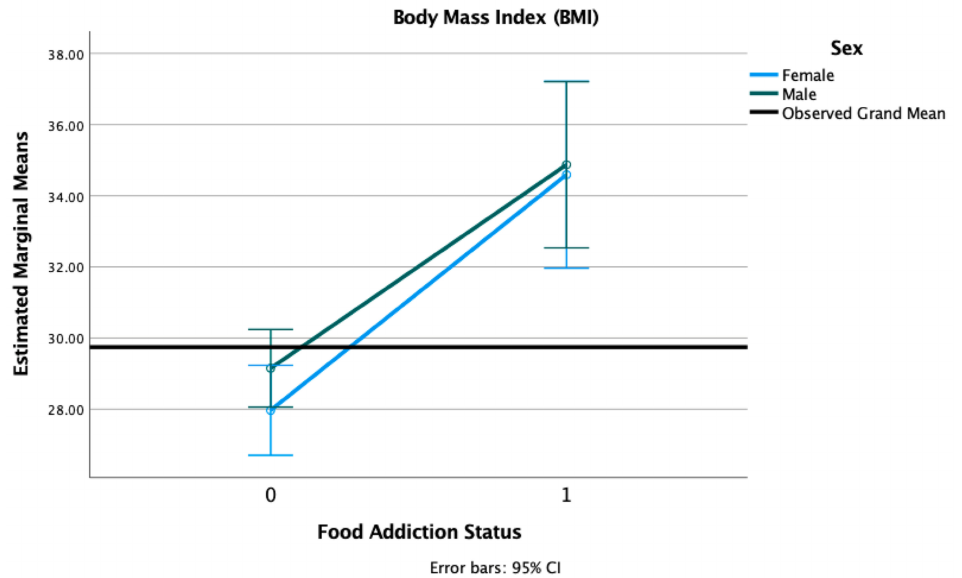
Figure 1. Estimated marginal means of body mass index (BMI) for a 2 × 2 factorial ANOVA with sex (female, male) and FA status (1 = positive, 0 = negative, on the X -axis) adjusted for age, race, and PTSD status (threshold vs. subthreshold).